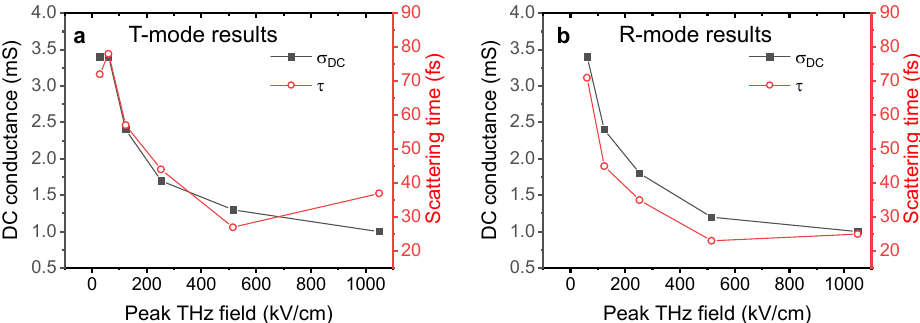
Figure 4. ( a ) DC conductance and scattering time obtained from Drude fits at various incident peak THz field strengths from the transmission-mode THz-TDS measurements. Solid squares: DC conductance. Open circles: scattering time. ( b ) The same parameters extracted from Drude fits reflection-mode